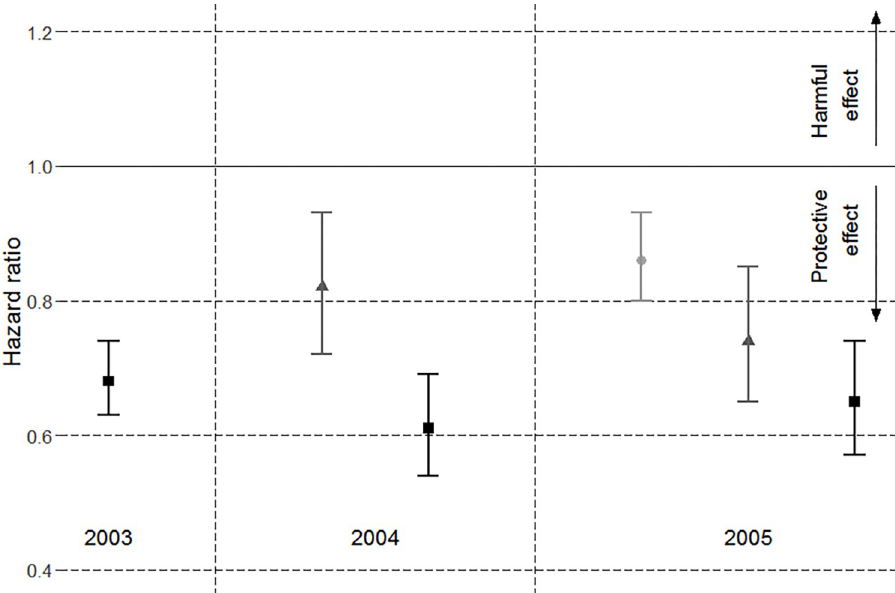
Fig 4. Pairwise-adjusted hazard ratios of vaccination for each annual cohort (2003–005) by sub-groups of age (65 to 74y –light grey circle; 75 to 79y –mid-grey triangles; 80+y–black squares.